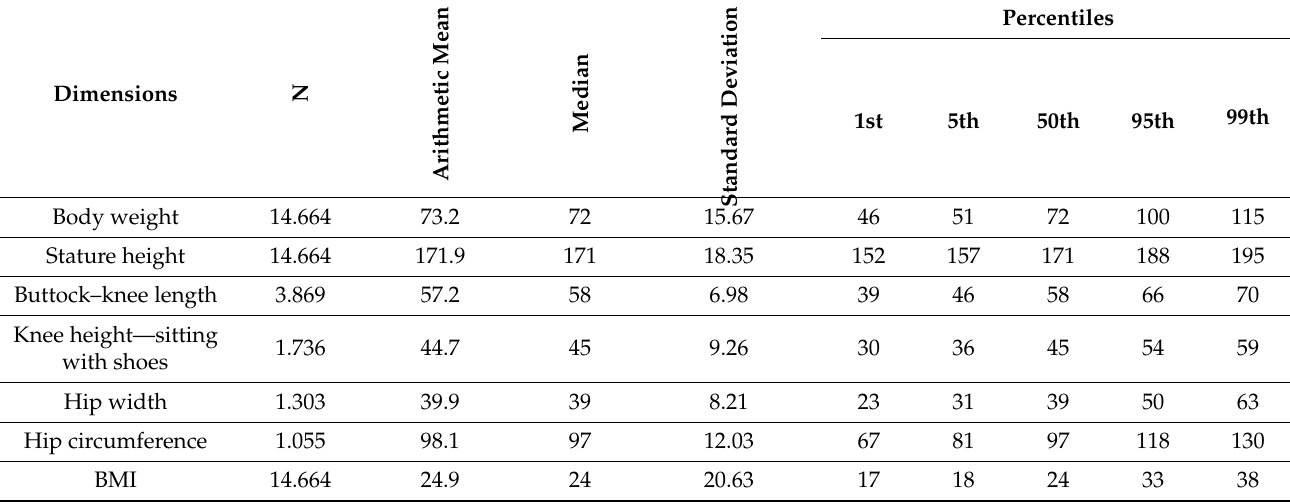
Table 1. Descriptive statistics of respondents aged 18–25 in